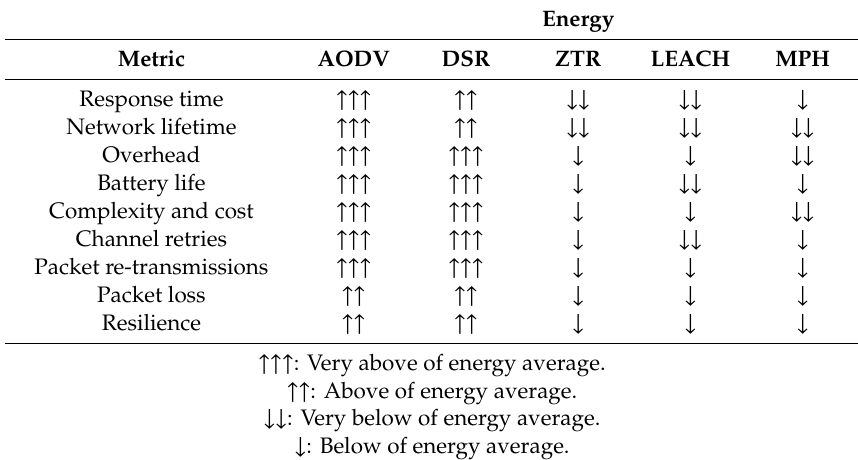
Figure 3. Power consumption vs Time sequence (t) of di ff erent phases for the Zigbee sensor node. Table 3. Energy behavior and technical features for the di ff erent performance